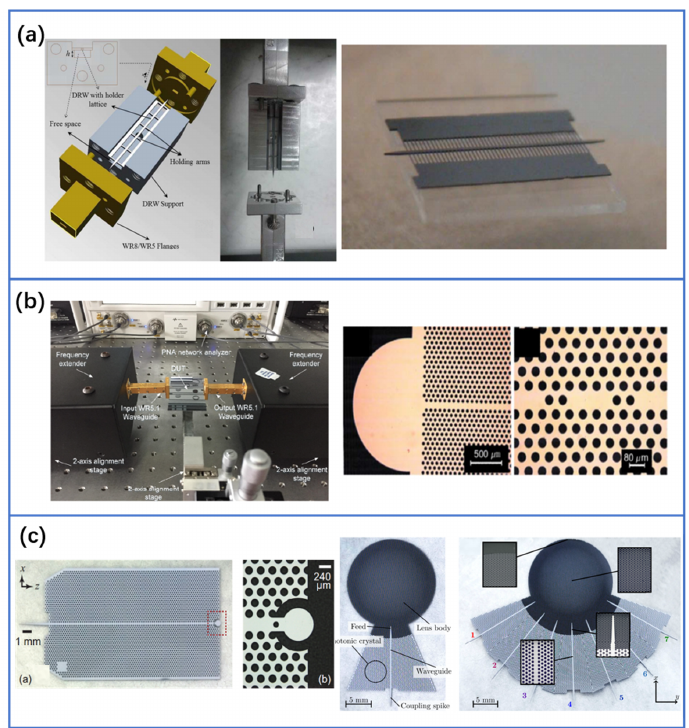
Figure 10. ( a ) THz silicon waveguides. © 2014 IEEE. Reprinted, with permission, from [62]. © 2015 IEEE. Reprinted, with permission, from [63]. ( b ) THz high-Q silicon cavities. Reproduced from [61], with the permission of AIP Publishing, 2009. Reprinted with permission from [64] © The Optical Society, 2018. ( c ) THz antennas implemented on silicon. Reprinted with permission from [59] © The Optical Society, 2017. Reproduced from [60], with the permission of AIP Publishing, 2018.